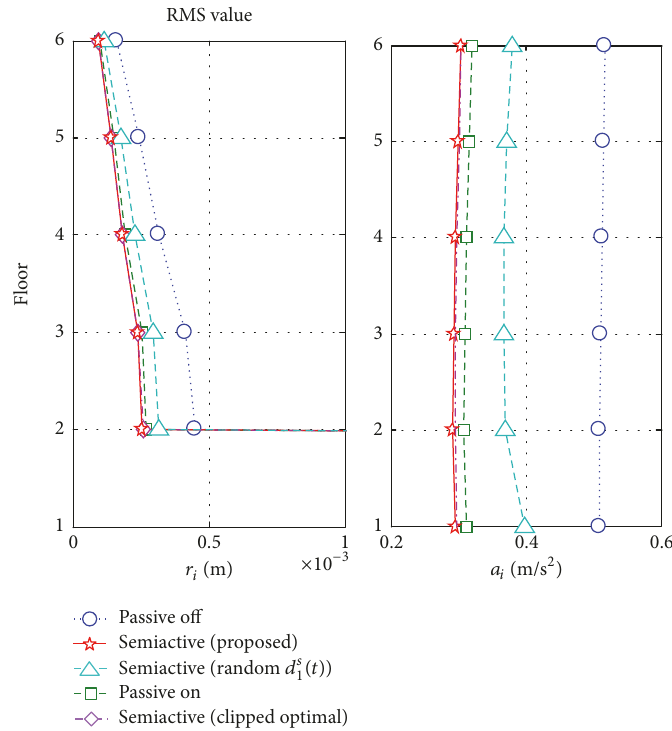
Figure 19: Simulation results for the Taft NS (1952) earthquake disturbance; RMS values of the relative displacement between neighboring floors and absolute acceleration of each